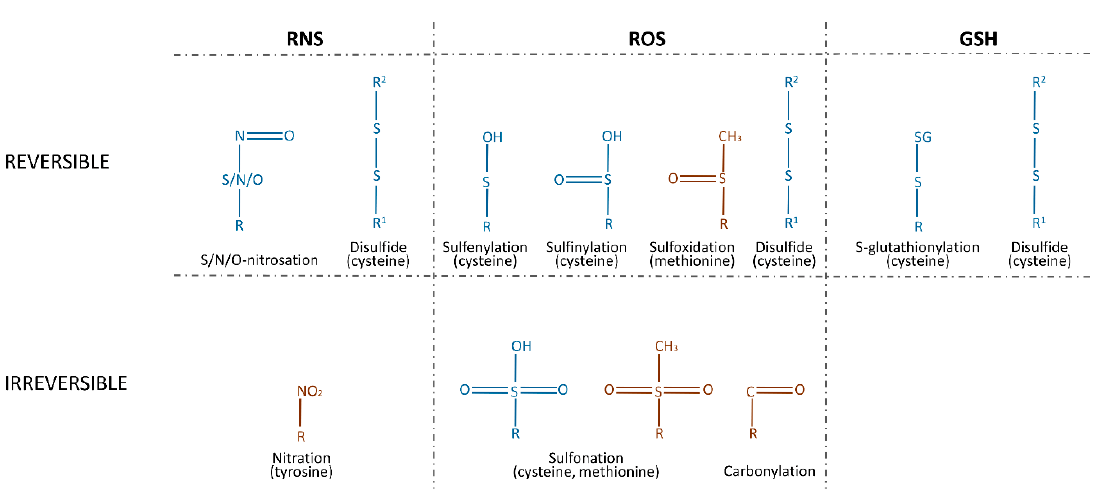
Figure 1. Reversible and irreversible redox-mediated post-translational modifications (PTMs) of amino acid residues. Amino acids that undergo modifications are indicated in parentheses. Modifications found for proteases are shown in blue.